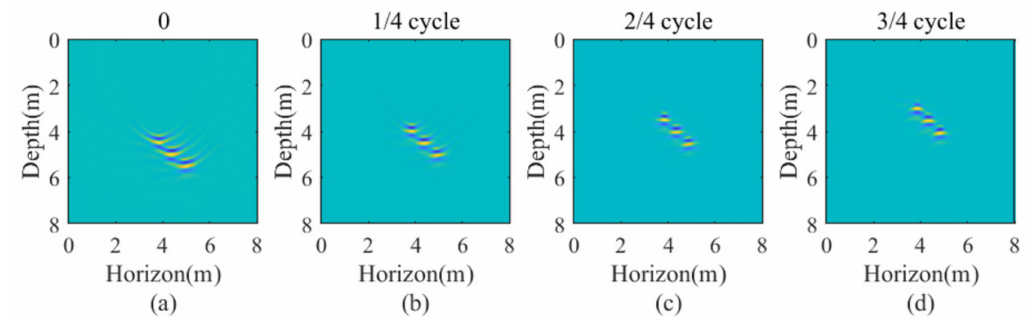
Figure 25. Imaging after time advance corrections: ( a ) no processing; ( b ) 1/4-cycle advance; ( c ) 1/2-cycle advance; ( d ) 3/4-cycle